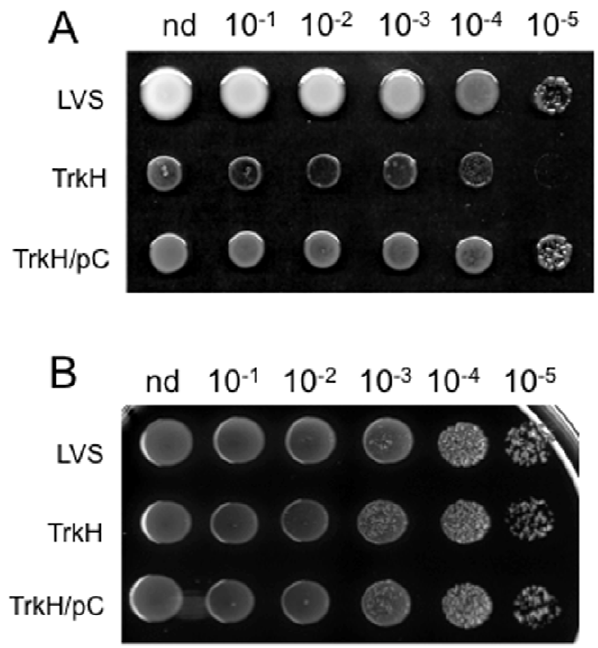
Figure 4. Functional complementation. Bacteria were grown in Schaedler K3 until an OD 600 of 0.3. Ten m l of each culture (nd: non diluted, corresponding to ca . 10 7 b) and of serial ten-fold dilutions, were spotted onto: CDM agar plate (A) and Chocolate agar plate (B). LVS: wild-type strain; TrkH: the trkH mutant derivative; TrkH/pC: the trkH mutant transformed with plasmid pC- trkH (a pFNLTP6 derivative carrying a wild-type trkH allele under control of the gro promoter).